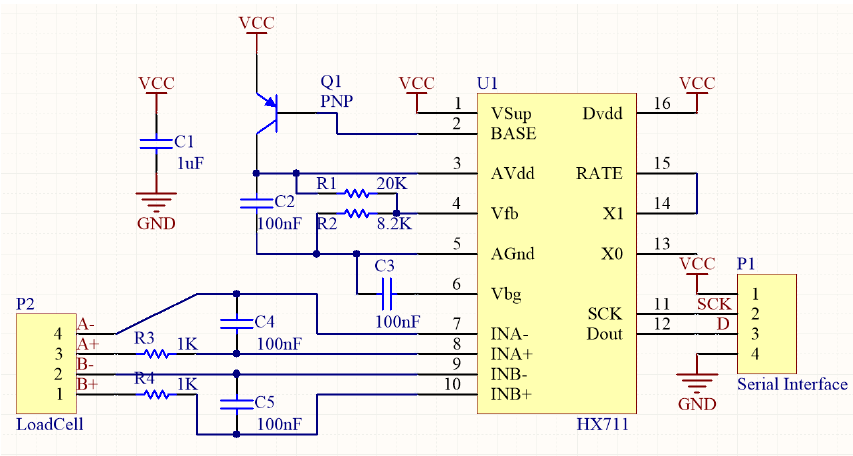
Figure 4. Circuit diagram for the strain gauge load cell, showing the Wheatstone Bridge.